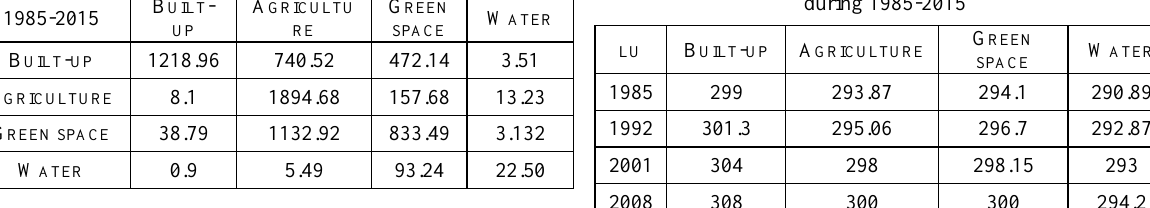
Table 5. Cross-tab of land use classes between 1985–2015 (ha)